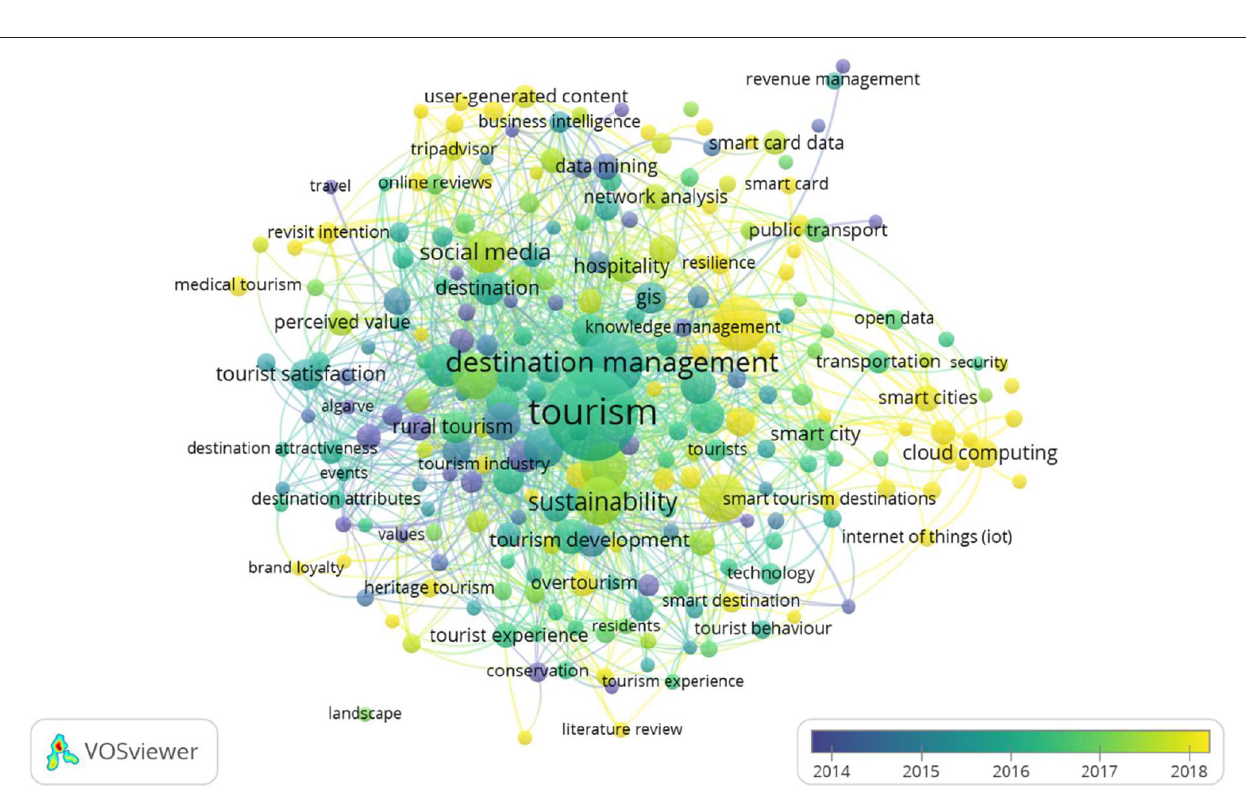
Frontiers in Psychology |